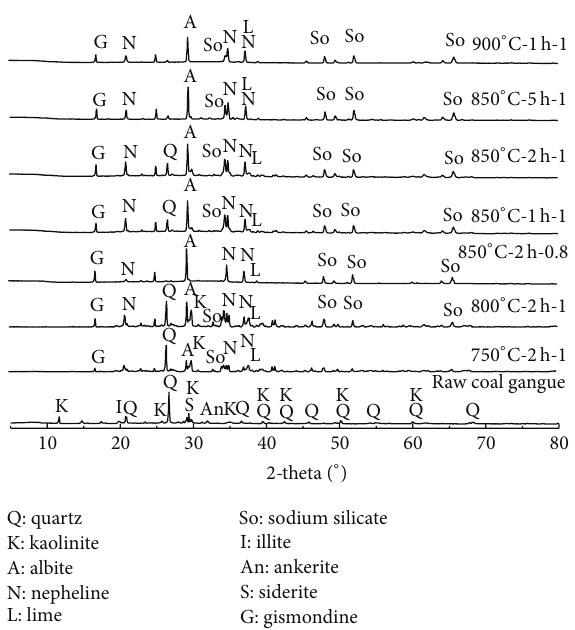
Figure 4: X-ray diffraction of coal gangue after Na 2 CO 3 activation and H 2 SO 4 wash and typical chemical formula of the mineral components: quartz (SiO 2 ), kaolinite (Al 2 Si 2 O 5 (OH) 4 ), albite